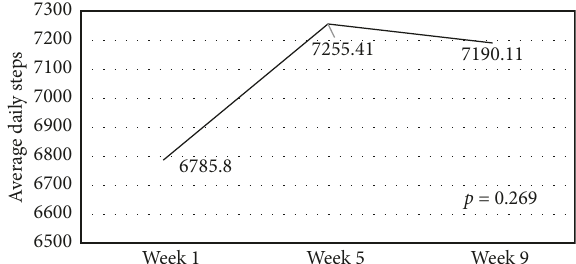
Figure 1: Footsteps count of participants during weeks 1, 5, and 9 ( N �